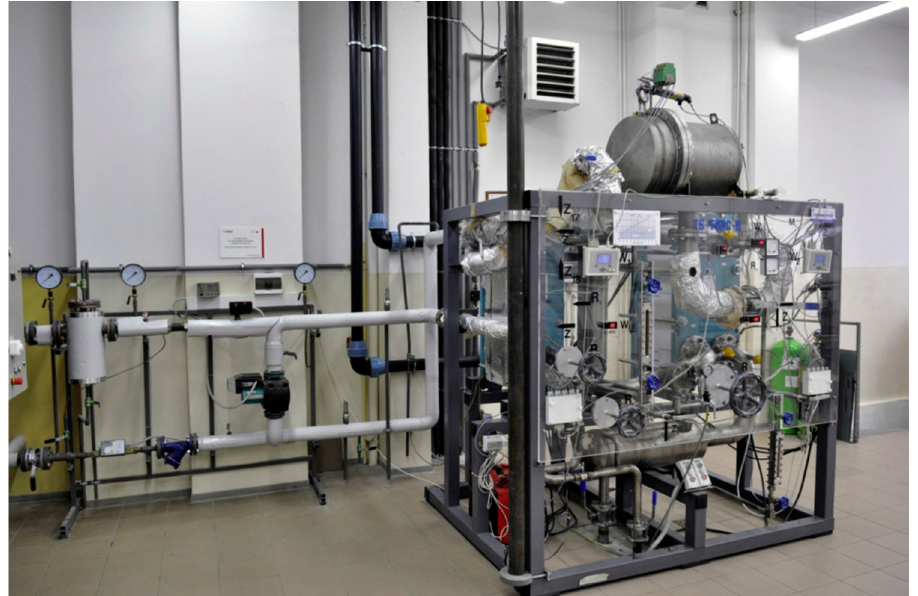
Figure 6. Picture of the ORC power plant.